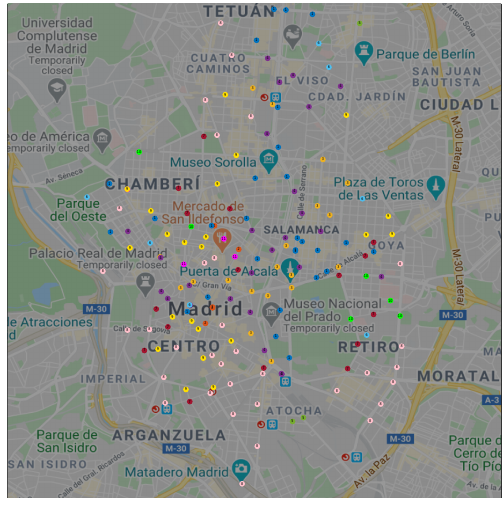
Figure 7. Spatial location of stations for 11